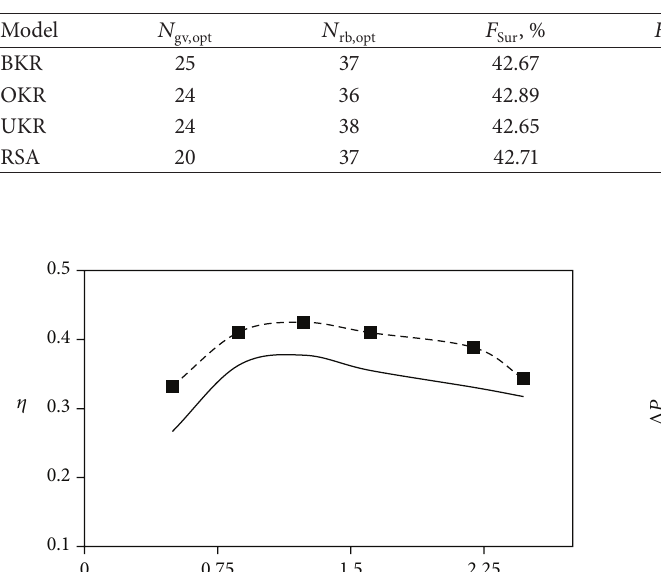
Table 4: Optimal designs for efficiency.